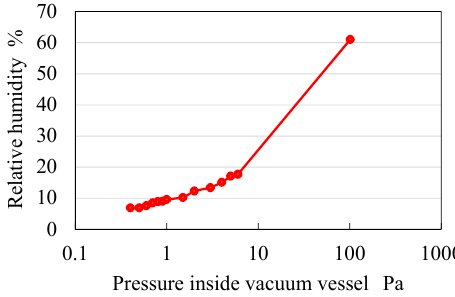
Figure 11. Relationship between pressure inside vacuum vessel and relative humidity.